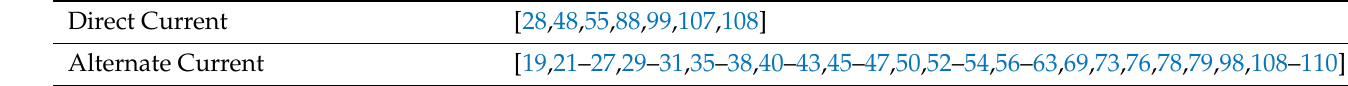
Table 4. Articles that can be classified by means of their current